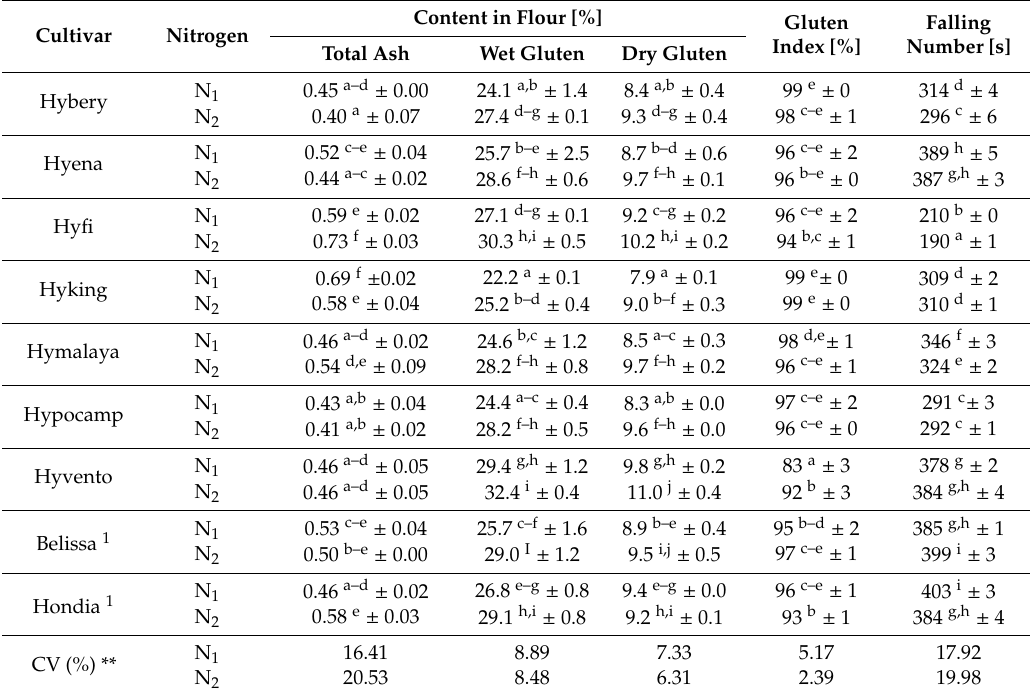
Table 2. Quality parameters of wheat flour from hybrid and population